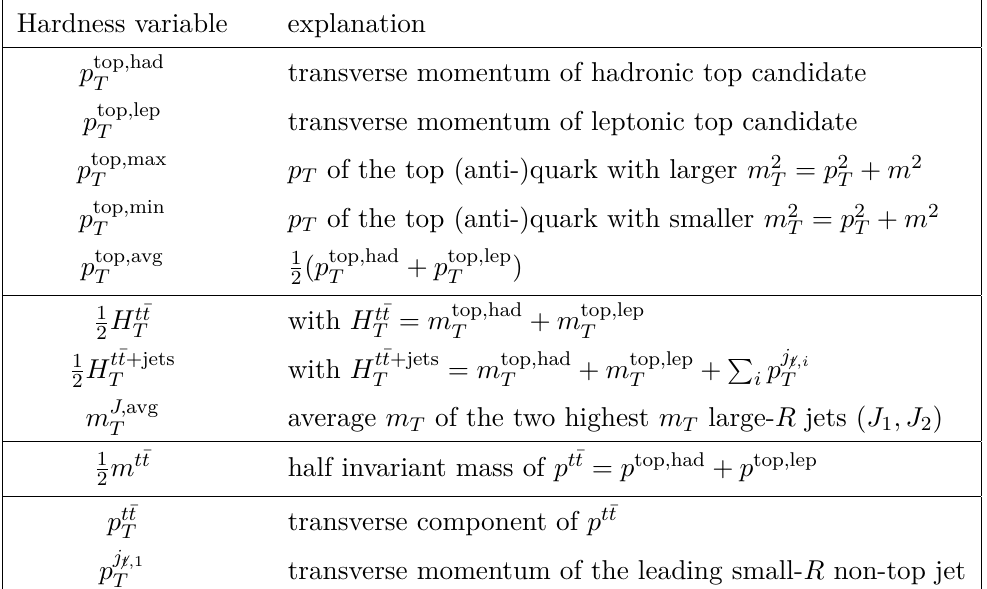
jets corresponds to i and p ordering for the p top,max and T T T